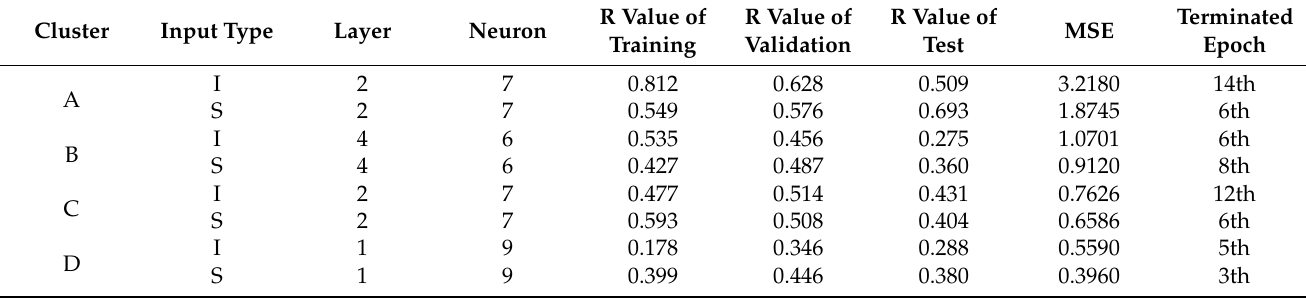
Figure 10. Cluster D model for crime occurrence prediction (layer: 1, node: 9); ( a ) Training data regression result; ( b ) Validation data regression; ( c ) Test data regression result. Table 6. Performances of prediction models according to the input data